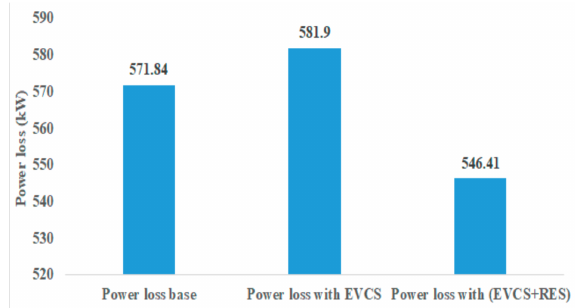
Figure 16. Power loss of the modified IEEE 123-bus